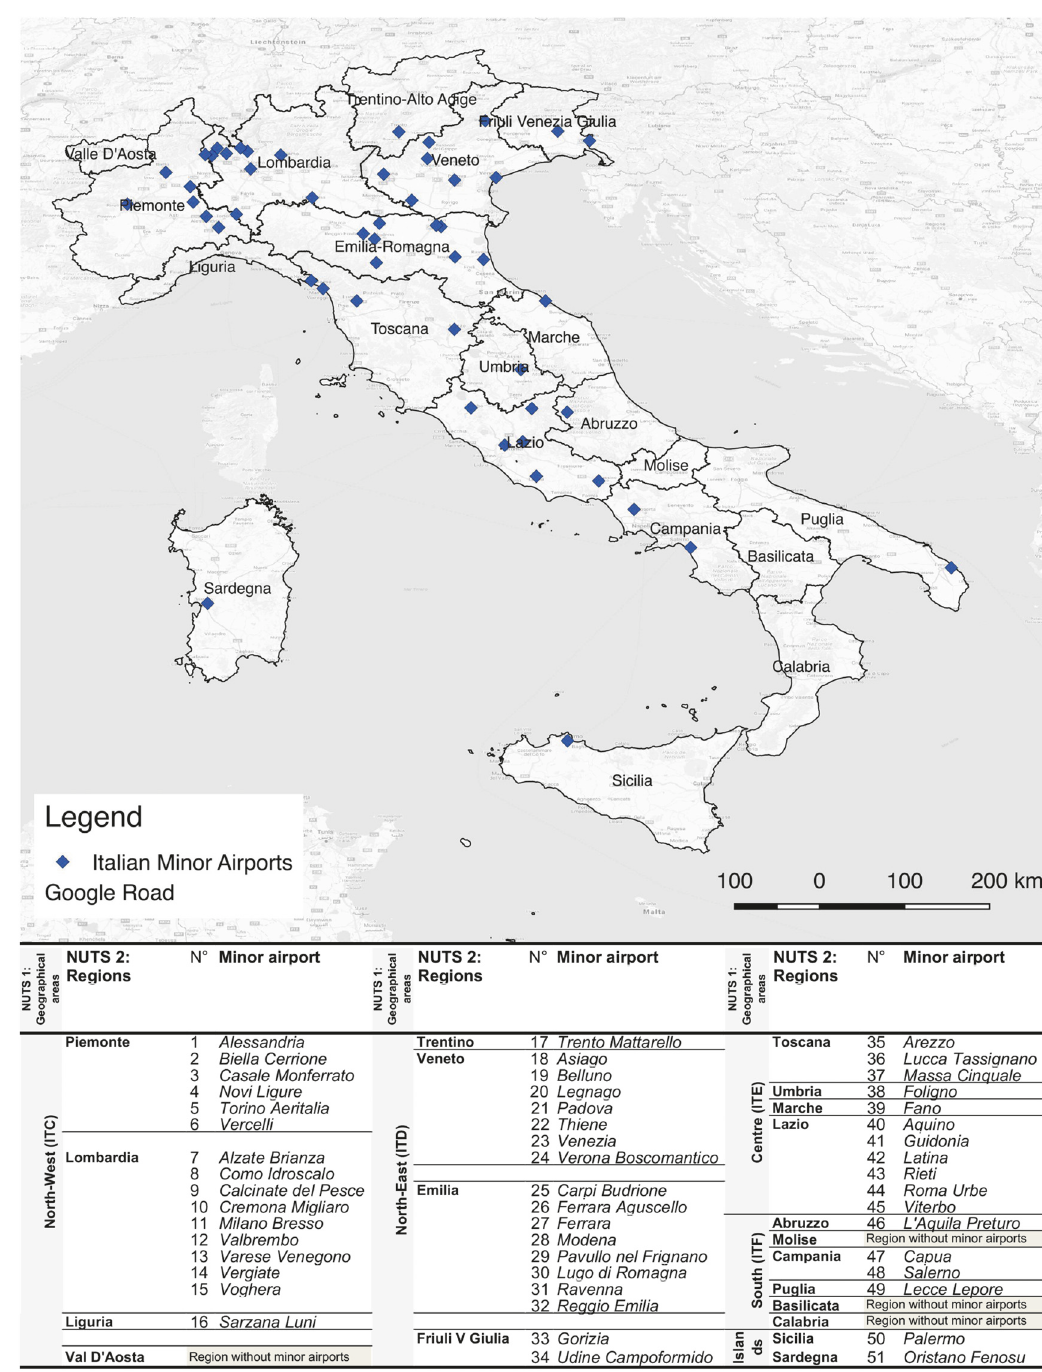
Figure 1: Italy’s minor